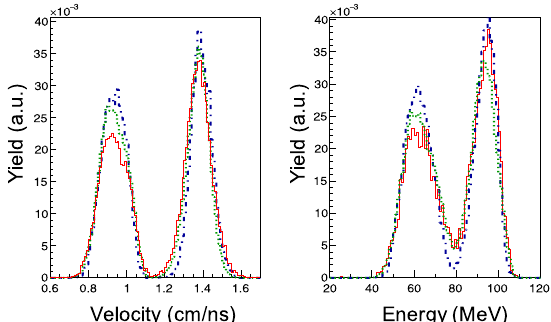
Fig. 4. 235 U FALSTAFF velocity and energy distribution (red curve) are compared to GEANT4 simulations with two different event generators: FIFRELIN (green dotted curve) and GEF (blue dashed